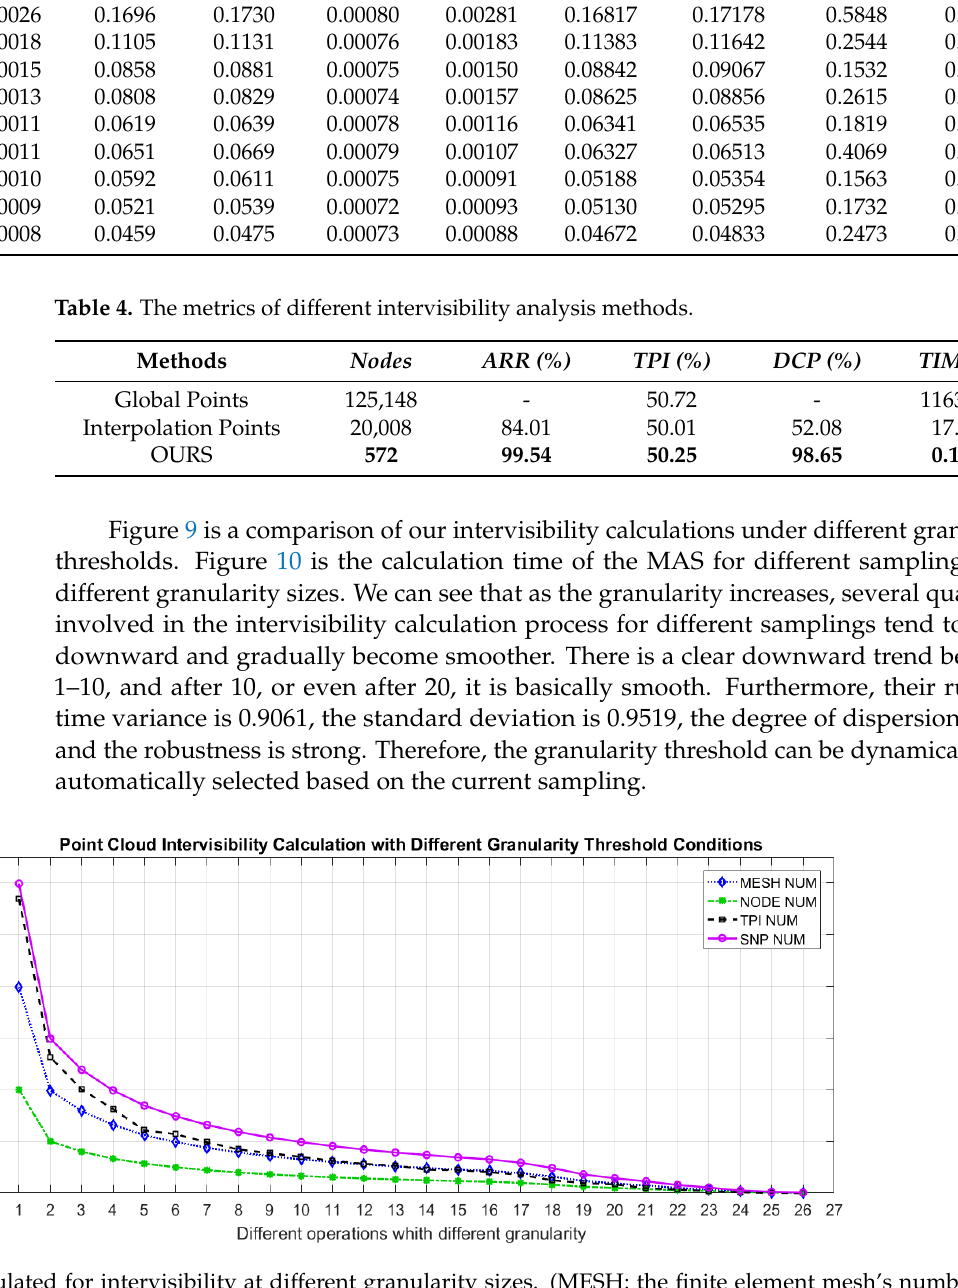
Figure 10. Times for samplings calculation at different granularity. Compared with the global point cloud and the local interpolation point clouds path- way-based method, our method does not directly process the original point cloud data. Our method effectively filters out excessive redundant noise 3D points. However, the de- letion of too many points will undoubtedly affect the integrity of the information. For example, it can lead to the lack of information about essential targets in the scene and terrain. Among the different node numbers calculated by different methods based on the same original data, we had fewer data points, but we guaranteed the same quality of the two-point intervisibility rate to a certain extent. Furthermore, to avoid the impact of information scarcity, it is indeed necessary to set and explore the minimum suppression threshold of the nodes number for automatic and dynamic collection requirements in future research. Moreover, the estimation of FOV is consistent with the actual motion scene of autonomous driving. The FOV estimation was necessary for dynamic analysis of autonomous driving scenarios because the original li- dar data was omni-directional, and the motion view of intelligent vehicles changed at any